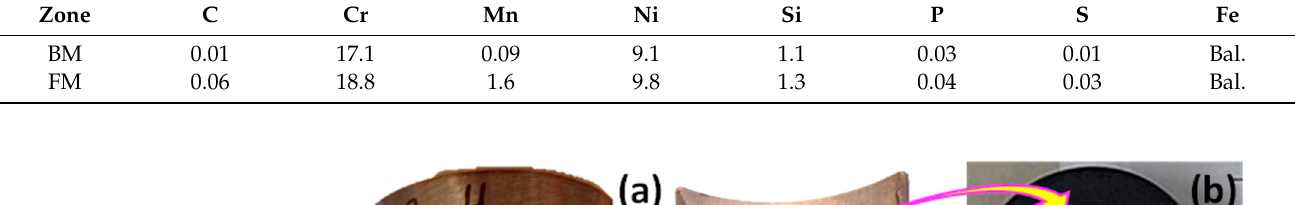
Table 1. Chemical composition for the studied steel base material (BM) and filler material (FM) (wt. %).